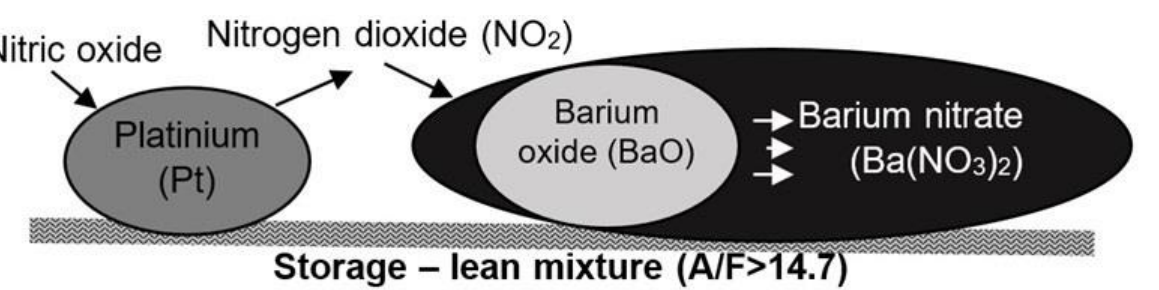
Figure 1. Diagram of the nitrogen oxide storage process in an LNT reactor.